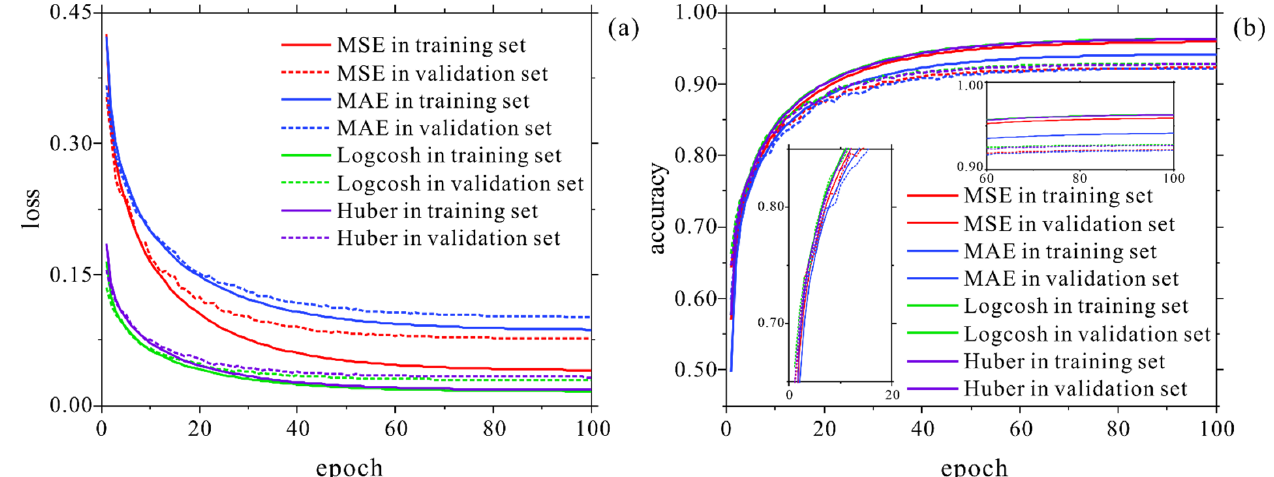
Figure 5. The model’s performance curve with different loss functions. ( a ) loss curve, ( b ) accuracy curve.